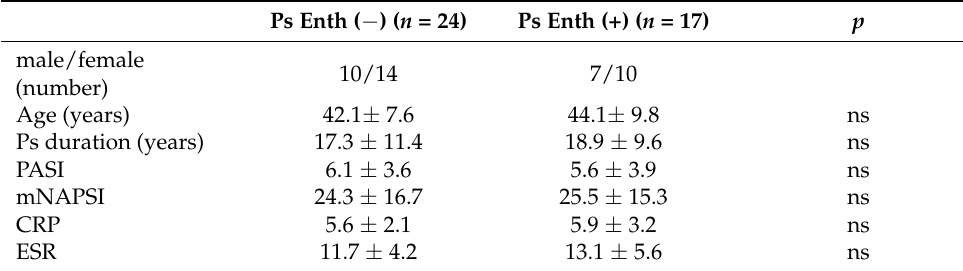
Table 1. Age and clinical characteristic of the patients studied. Ps Enth ( − ) ( n = 24) Ps Enth (+) ( n =